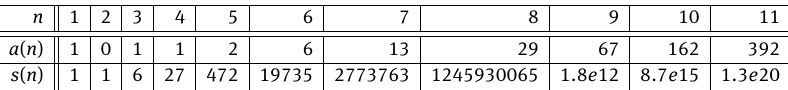
Table 16: The number a ( n ) of acute 0/1 n -simplices related to their total number s ( n ) .